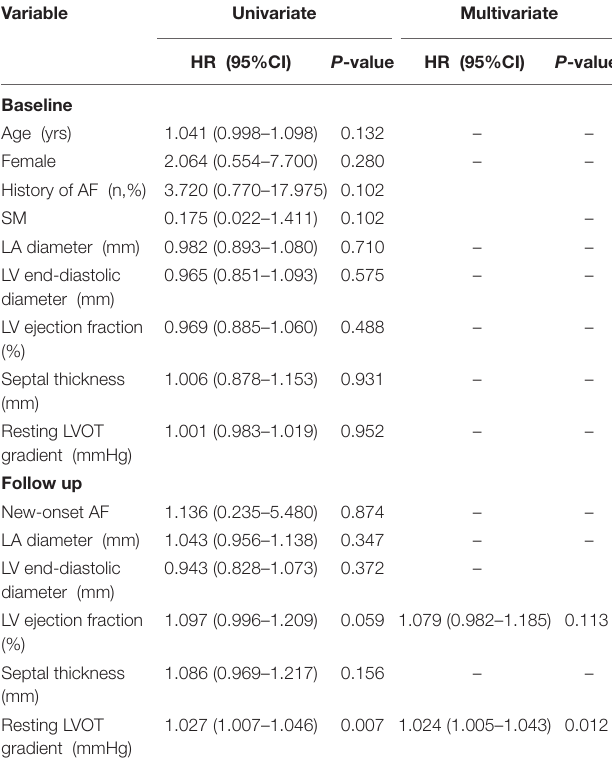
TABLE 4 | Predictors of HCM-related mortality.